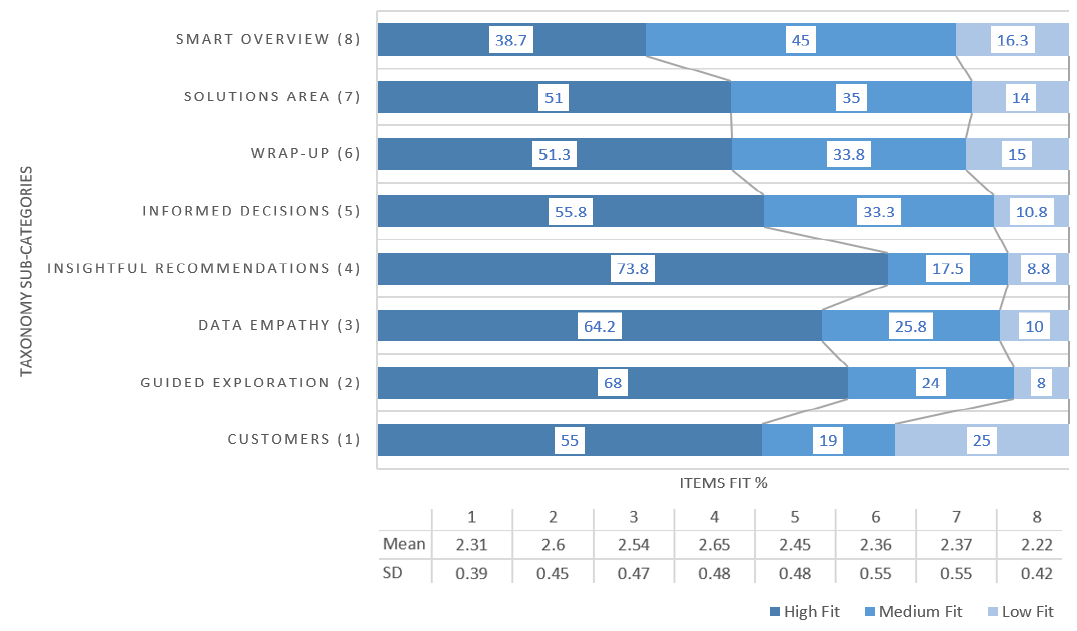
Figure 7. Distribution of items fit in the taxonomy